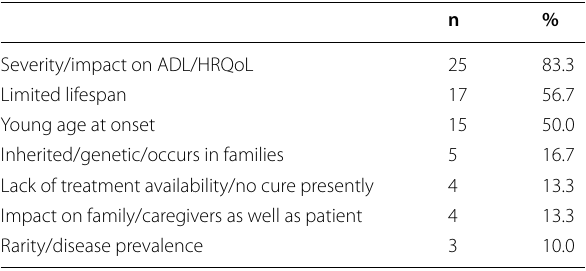
Table 3 Attributes identified by respondents as important for DMD research and treatment (n =